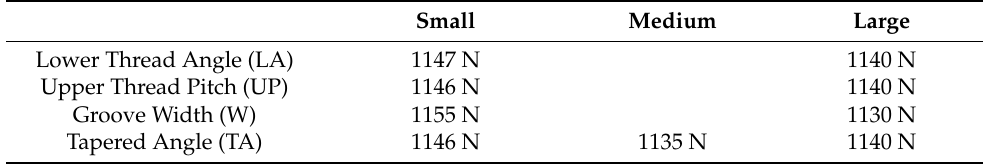
Table 2. Comparison of average pullout strength of four different design factors in 20